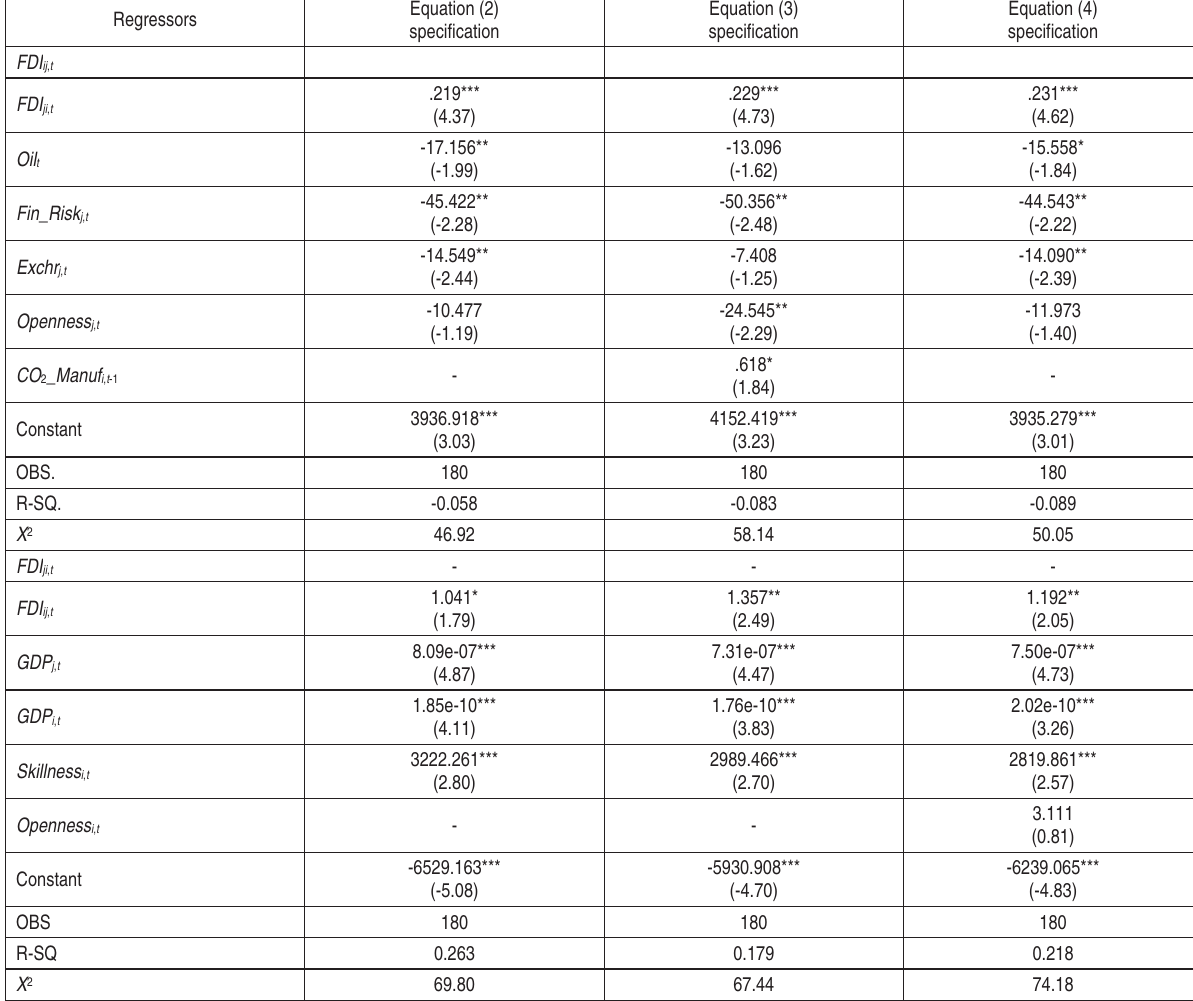
Table 2. Empirical findings for simultaneous equation